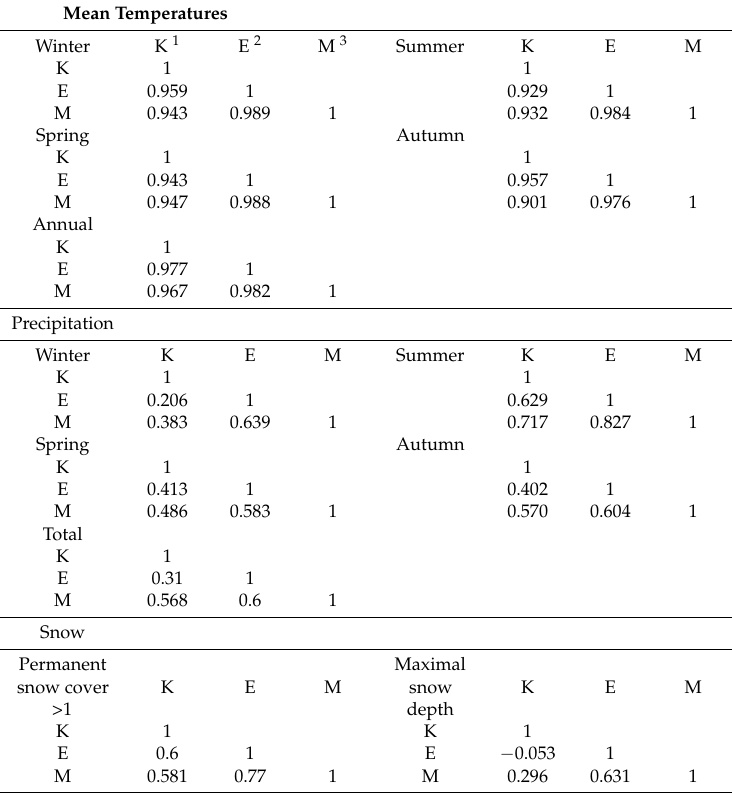
Table 2. Pearson correlation coefficients (r) between the different meteorological stations concerning the average temperatures, precipitation and snow